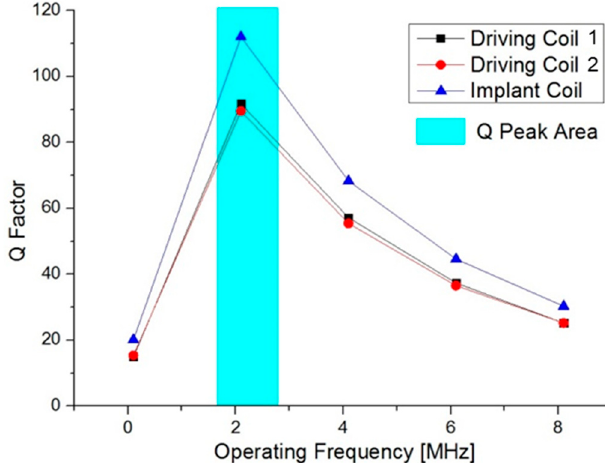
Figure 3. Inductance simulation of driving coils and implant coil with multi-layer and multi-turn versus different frequency.